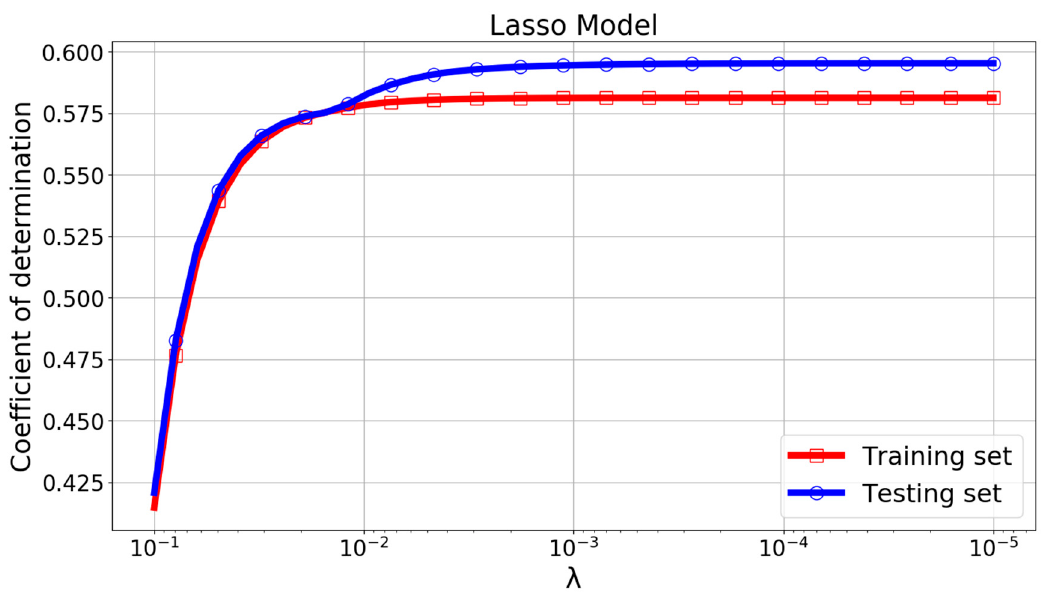
2 change curve of the Lasso model with parameter λ . Geosciences 2020 , 10 , x FOR PEER REVIEW